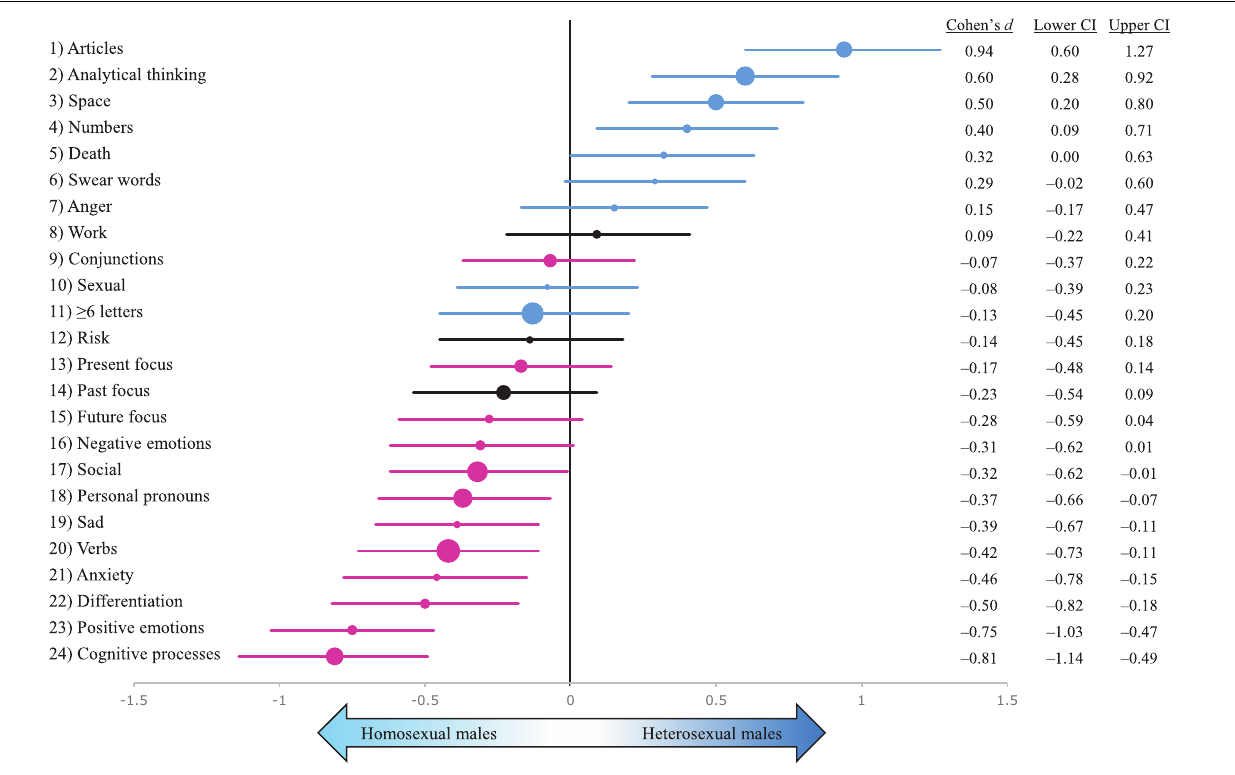
FIGURE 2 | A summary of multilevel sexual orientation effect sizes (Cohen’s d s) with 95% confidence intervals (CI) on 24 psycholinguistic variables. The sample comprised 318 novels by 86 heterosexual male novelists ( n = 151 novels) and 55 homosexual male novelists ( n = 167 novels). Cohen’s d s for each psycholinguistic variable are depicted as filled circles, which are scaled to reflect the prevalence of each word category in the sample: the larger the circle, the more frequently do words in that category occur in the sample. Positive d s represent higher scores in heterosexual male authors’ novels; negative d s indicate higher scores in homosexual male authors’ novels. Error bars represent 95% confidence intervals. The effect sizes and CIs presented here are calculated based on a multilevel model which includes publication year and author’s age at publication as covariates. The symbols are colour-coded based on the sex difference results ( Supplementary Table 8 ) so that blue = male-typical; magenta = female-typical; black = no sex